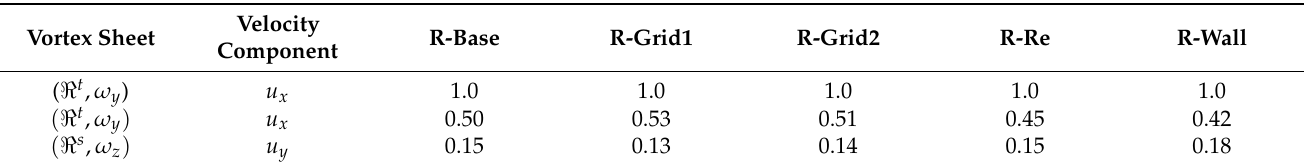
Table A4. Normalised vortex sheet strengths for the AR=1 canyons, velocity is averaged over each vortex sheet.